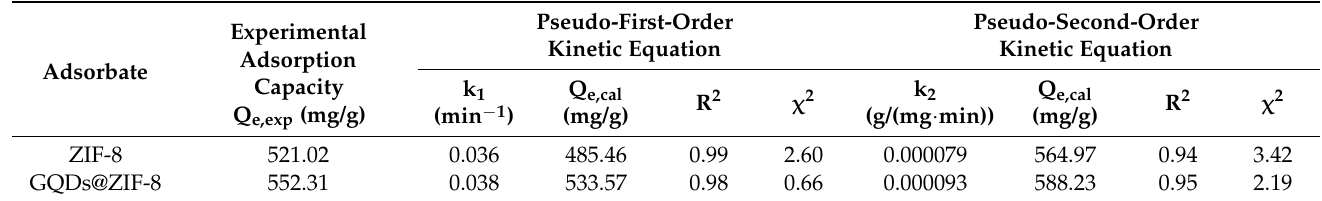
Table 2. Adsorption kinetic parameters of ZIF-8 and GQDs@ZIF-8 for toluene adsorption.